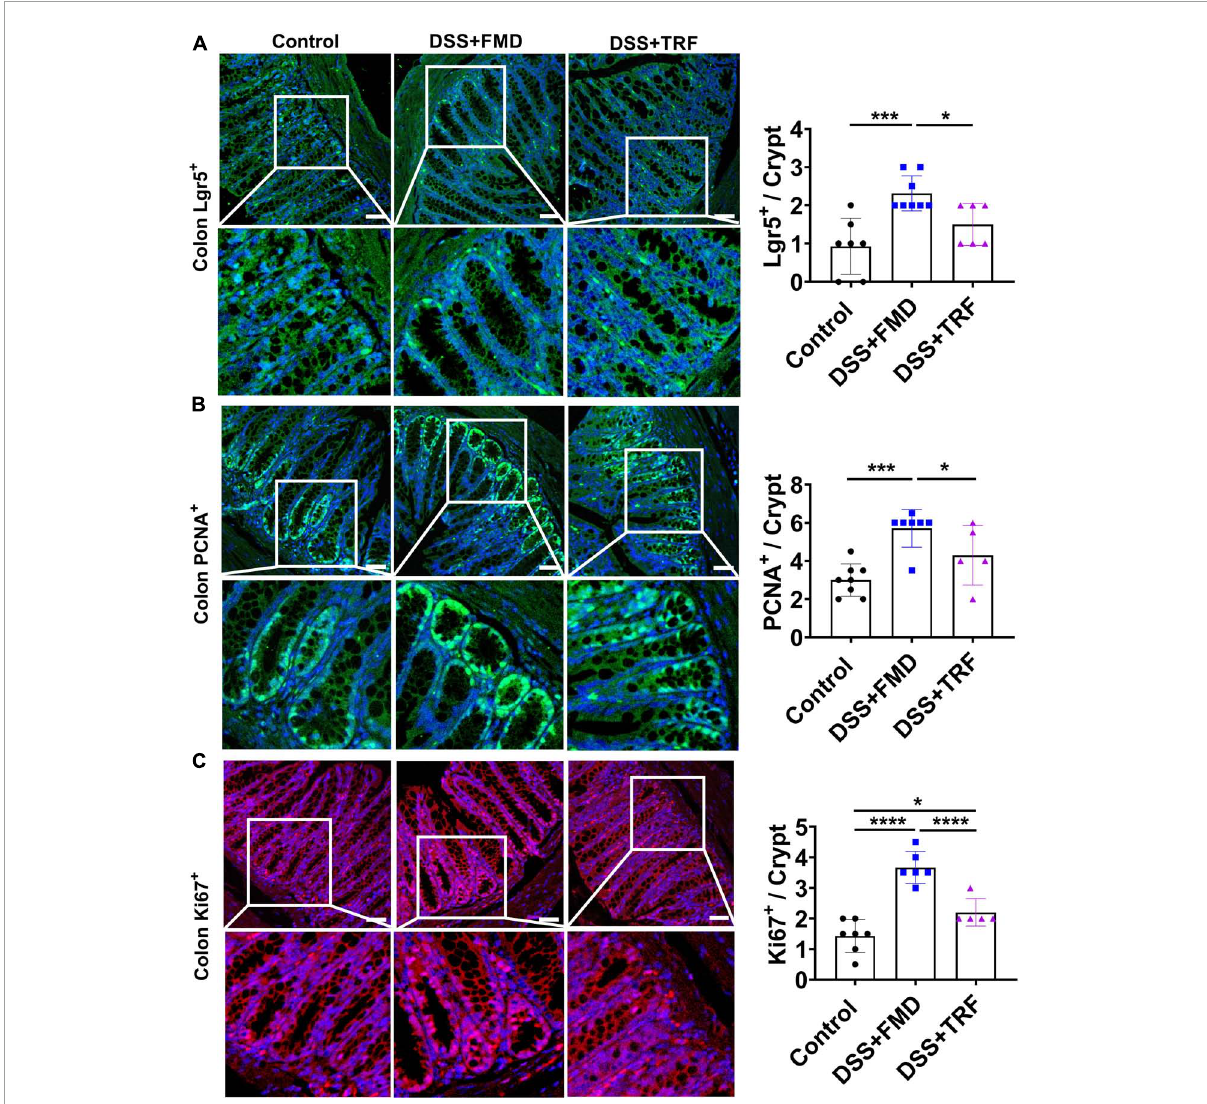
FIGURE6 FMD but not TRF increases the markers of progenitor and proliferating cells in colon. (A) Representative images of Lgr5 + immunofluorescent (IF) staining in the colon (red color). Quantitation of Lgr5 + cells in the crypt of colon is shown on the right ( n = 6 to 8 for each group). (B) Representative images of PCNA + IF staining in the colon. Quantitation of PCNA + cells in the crypt of colon is shown on the right ( n = 5 to 8 for each group). (C) Representative images of Ki67 + IF staining in the colon. Quantitation of Ki67 + cells in the crypt of colon is shown on the right ( n = 5 to 7 for each group). Data are presented as mean ± SEM; * P < 0.05, *** P < 0.001, **** P < 0.0001. IF images were taken at 20 X magnification. Scale bar: 50 µ